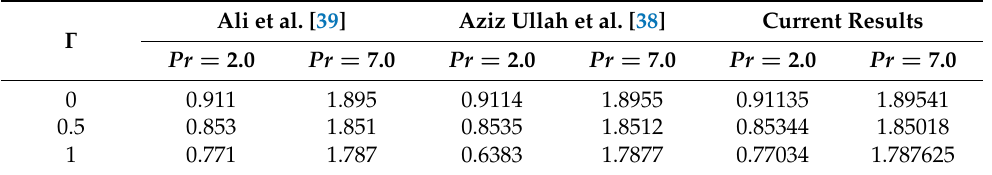
Table 2. Comparison values of Θ (cid:48) ( 0 ) with various values of Γ and Pr . Ali et al. [39] Aziz Ullah et al. [38] Current Results Γ Pr = 2.0